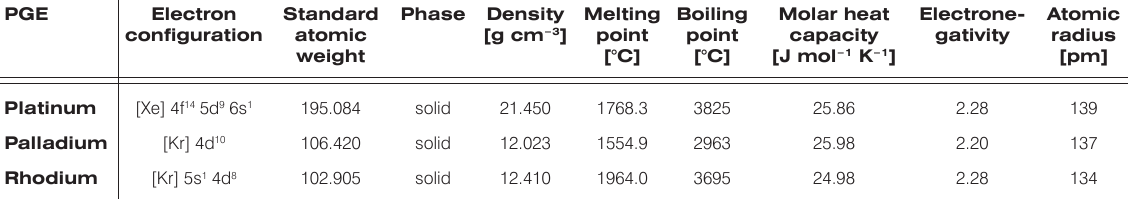
Table 1. Physical and chemical properties of platinum, palladium and rhodium [19-22].